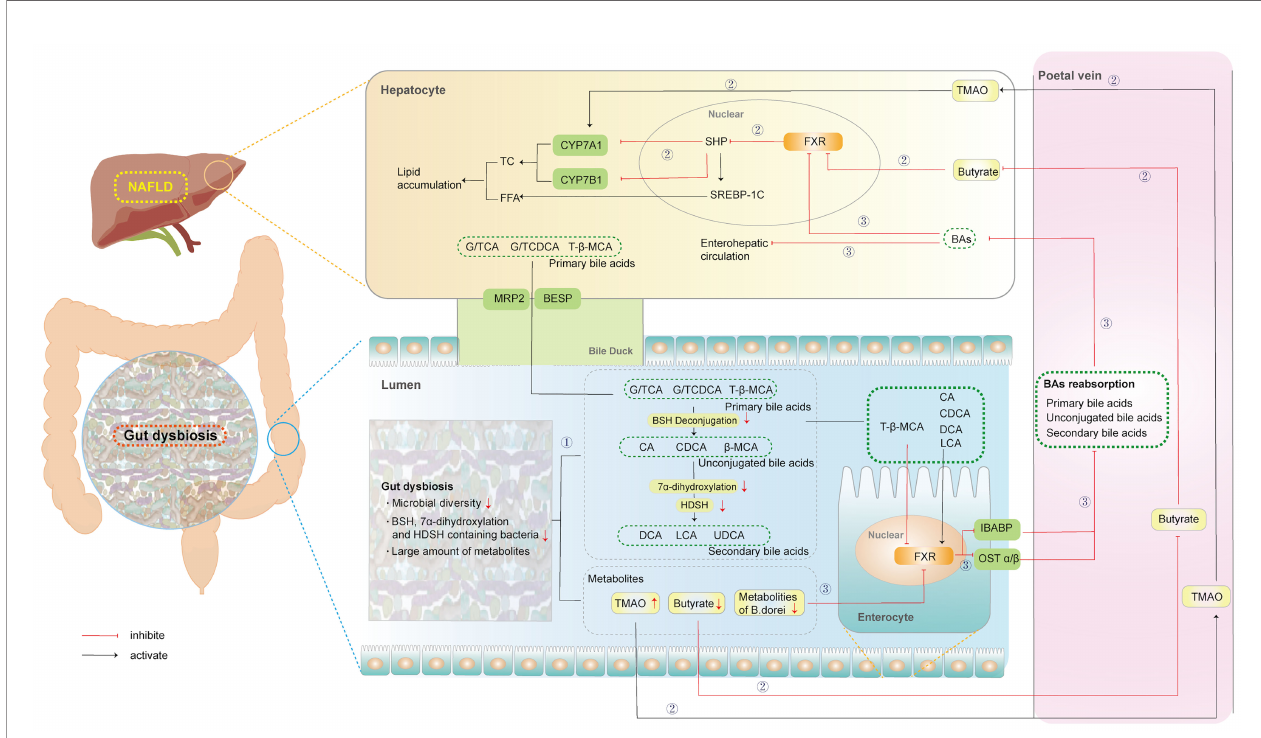
FIGURE 1 | Microbial regulation of Bile Acids in NAFLD. ① : Microbial modi fi cation of primary BAs to secondary BAs. ② : Microbial regulation of BAs synthesis. ③ : Microbial regulation of BAs transport, and reabsorption. (BESP, bile salt export pump; MRP2, multidrug resistance protien 2; BAs, bile acids; BSH, bile salt hydrolase; b -MCA, b - murocholic acid; CA, Cholic acid; CDCA, Chenodeoxycholic acid; CYP7A1, cytochrome P450 family 27 subfamily A member 1; CYP7B1, cytochrome P450 family 7 subfamily B member 1; DCA, deoxycholic acid; FXR, farnesoid X receptor; FFA, free fatty acid; IBABP, ileal bile acid binding protein; LCA, lithocholic acid; NAFLD, non- alcoholic fatty liver disease; SHP, small heterodimer partner; SREBP-1, sterol regulatory element binding protein-1; T b MCA, tauro- b -muricholic acid; TC, total cholesterol; TMAO, trimethylamine oxide; UDCA,